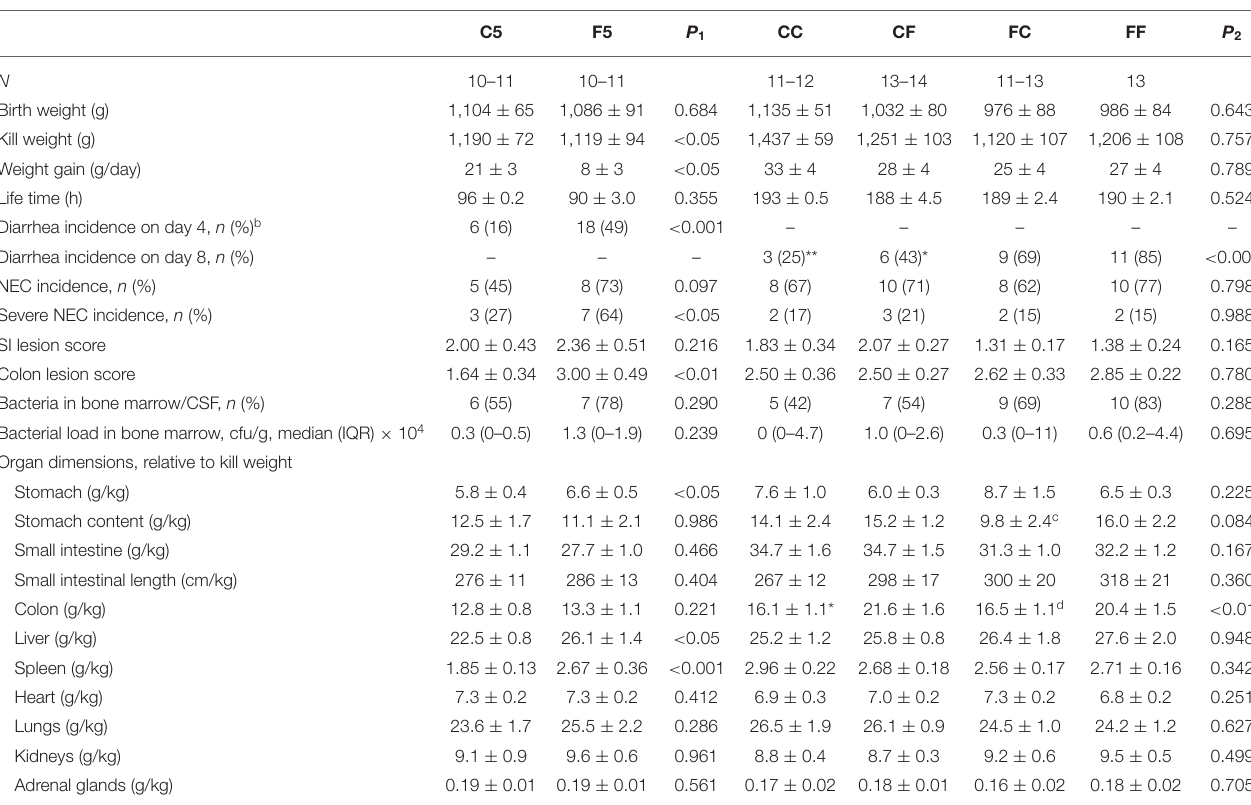
TABLE 3 | Clinical outcomes and organ dimensions a .